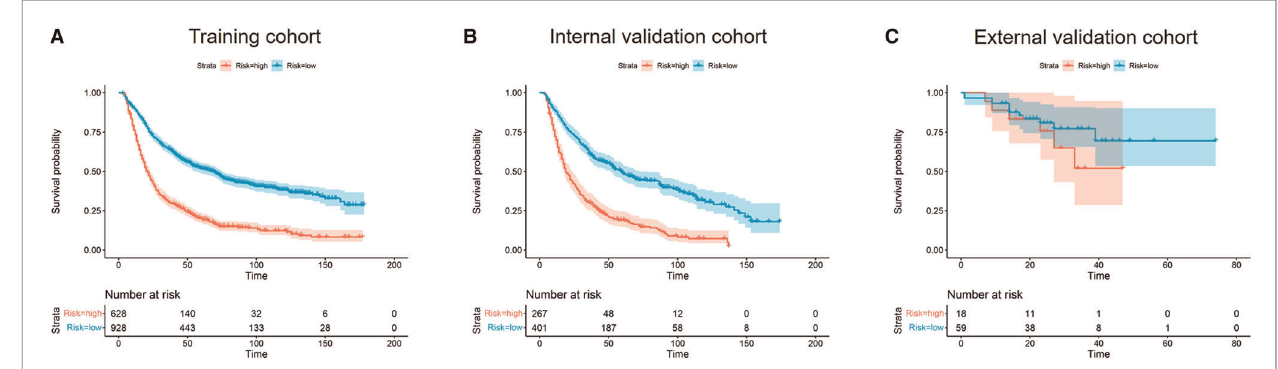
FIGURE 5 | Kaplan – meier curves of OS for risk strati fi cation in the training cohort ( A ), internal validation cohort ( B ), and the external validation cohort ( C